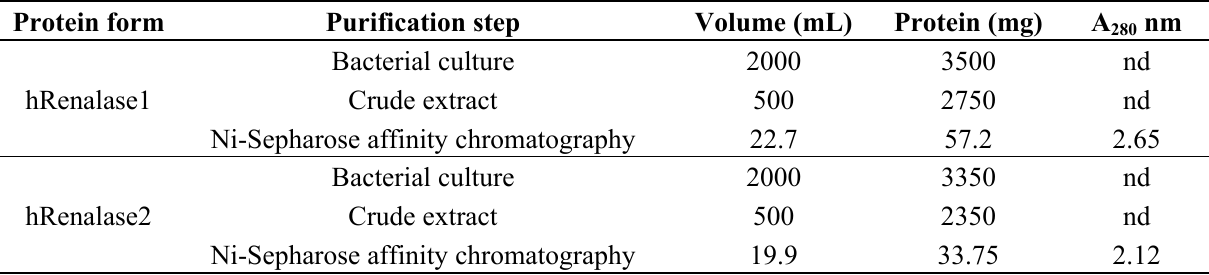
Table 2 . Purification of human polyHis-renalases 1 and